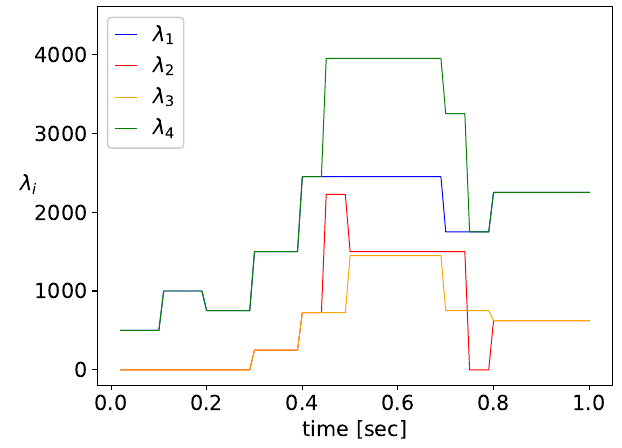
Figure 12. Input flows λ i ( t ) for stations S 1 ... S 4.